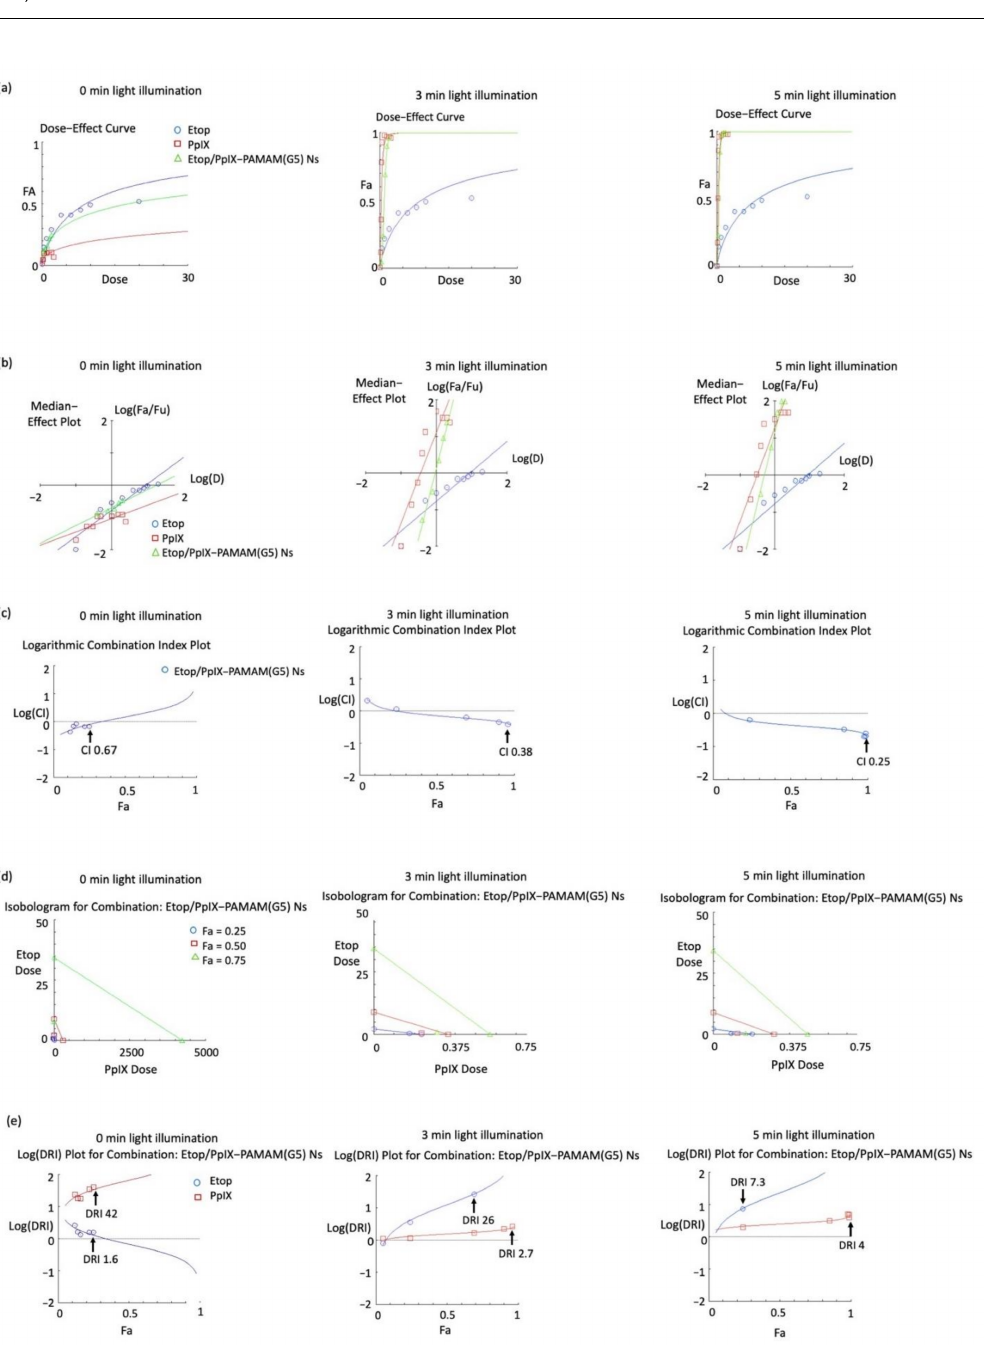
Figure 6. The graphical outputs from the CompuSyn software using cytotoxicity data for Etop, PpIX PDT, and Etop/PpIX- PAMAM(G5) Ns phototherapy. ( a ) Incorporation of Etop and PpIX into the Ns showed mixed effects when compared with Etop alone, the dose effect ranged from synergism in the low dose range to antagonism in the high dose range in the absence of light illumination; 3 min light illumination resulted in an earlier climb to plateau than Etop plus PpIX. ( b ) The light- dependent effect PpIX PDT and Etop/PpIX-PAMAM(G5) Ns phototherapy was manifested by a shift in the x-intercept on the median effect plot with PpIX PDT being more potent than Etop/PpIX-PAMAM(G5) Ns phototherapy. ( c ) Synergism was observed with 0 min of light illumination but only in the low Fa range, whereas synergism and strong synergism were seen with 3 min and 5 min light illumination in the high Fa range, respectively. ( d , e ) The isobologram appeared very similar to phototherapy with Etop plus PpIX in which a favorable dose reduction was possible in the high Fa range especially for Etop and less so for PpIX. (CI—combination index, DRI—dose-reduction index, Etop—etoposide, PAMAM(G5) Ns—generation-5 polyamidoamine dendrimer nanosphere, PDT—photodynamic therapy, PpIX—protoporphyrin